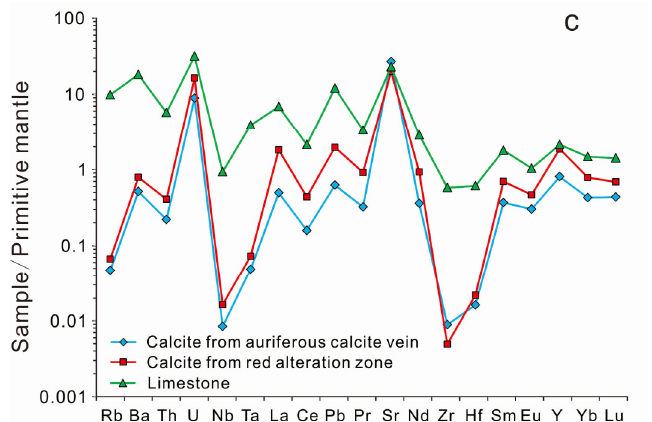
Figure 6. Trace elements distribution patterns of hydrothermal calcite and country rocks in Phapon. All samples are normalized to primitive mantle [50]. ( a ) Calcites from auriferous calcite vein and red alteration zone, respectively; ( b ) limestone and sandstone; ( c ) average value of two types of calcite and limestone.